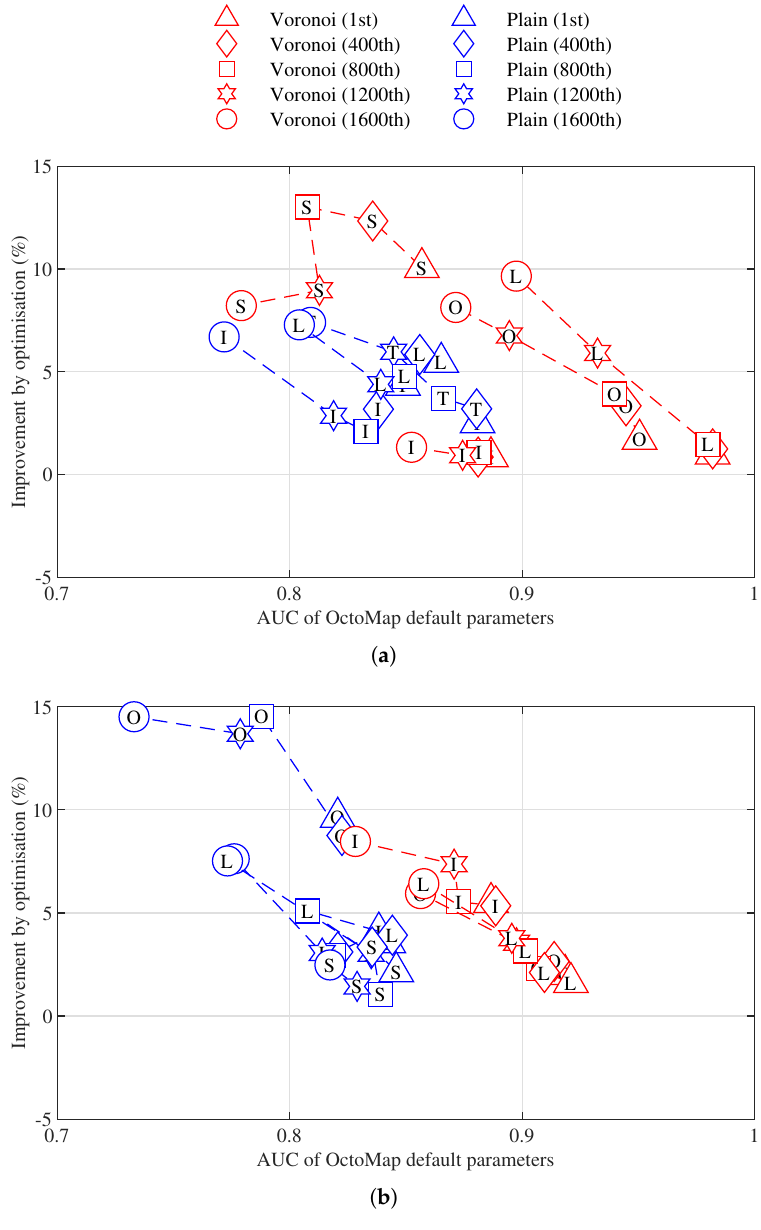
Figure 6. Improvement by optimisation over the area under the curve (AUC) of OctoMap default parameters on training data sets. ( a ) Building. ( b ) Parking